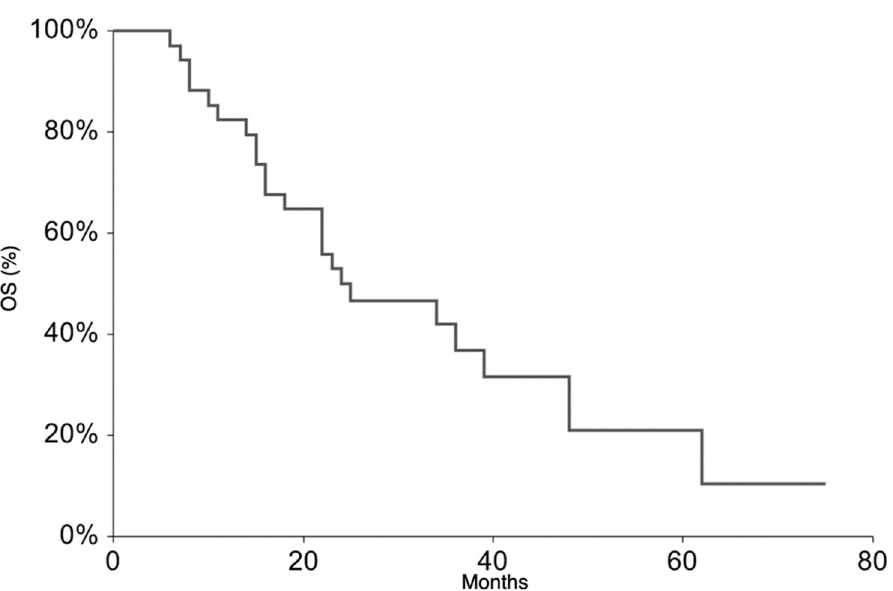
Figure 2. Overall Survival for the whole patient group.